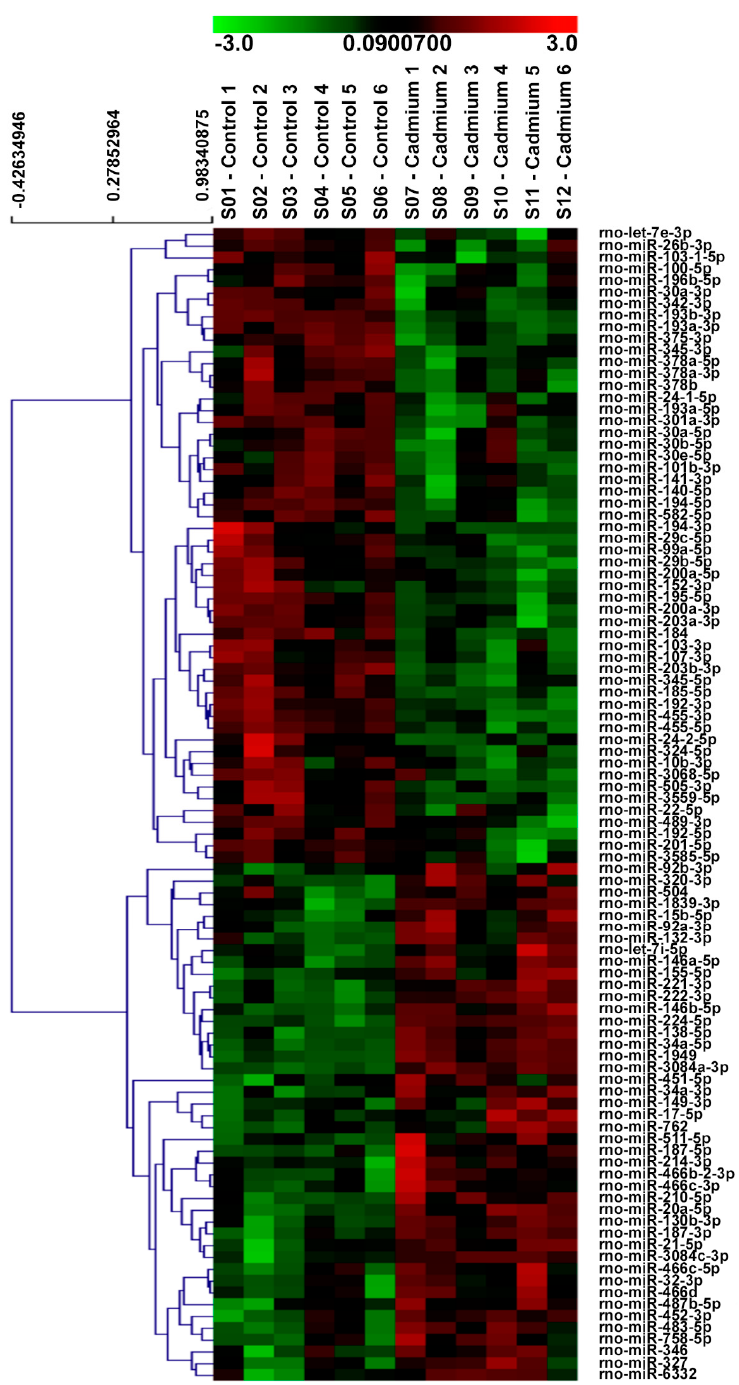
Figure 2. Effects of Cd on miRNA expression in the rat renal cortex. Microarray heat map demonstrating significant differences in the expression of miRNAs in the renal cortex of Cd-treated (0.6 mg/kg/day, 5 days per week for 12 weeks) male Sprague-Dawley rats versus saline controls. Cadmium significantly decreased the expression of 54 miRNAs and increased the expression of 44 miRNAs ( N = 6 per group, unpaired t -test, p ≤ 0.05).